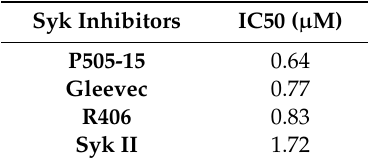
Table 1. IC 50 values obtained from the densitometry analysis performed on anti-p-Tyr Western blotting membranes.